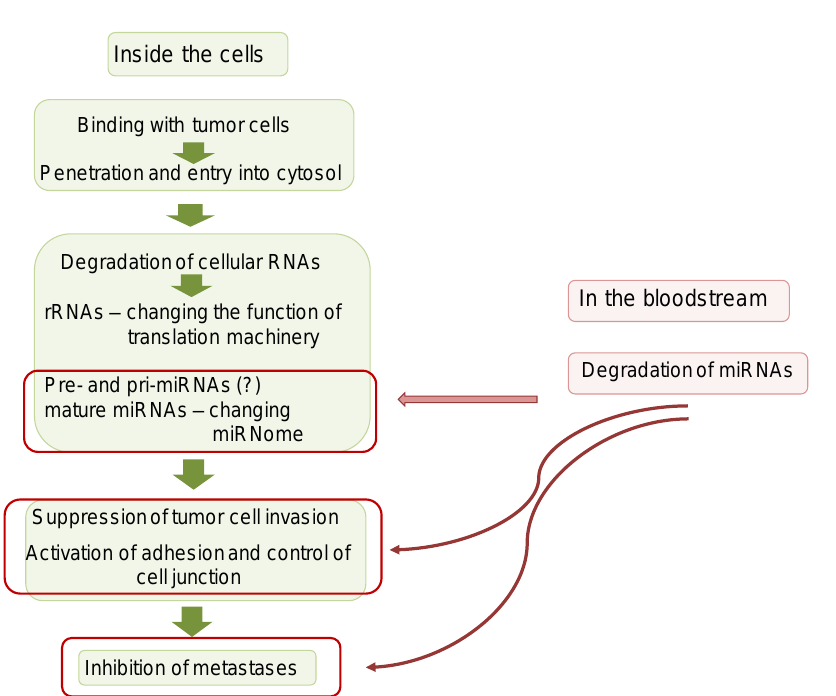
Figure 10. Hypothetical mechanism of antitumor activity of RNase A.